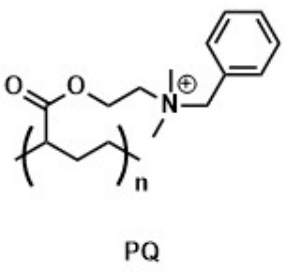
Figure 18. Structure of poly [N-benzyl-2-(methacryloxy)-N, N-dimethylethanaminium bromide] (PQ).